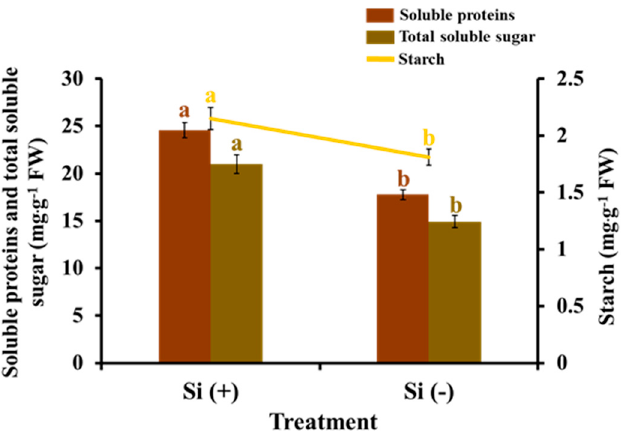
Figure 7. Effect of 30 days of silicon application on the accumulation of carbohydrates and soluble proteins in the coffee plants grown in plant growth chambers. Si (+) and Si ( − ) refer to 75 and 0 mg·L − 1 , respectively. Vertical bars indicate the means ± standard error ( n = 6). Different lowercase letters indicate the significant separation within treatments by the Duncan’s multiple range test at p ≤ 0.05.